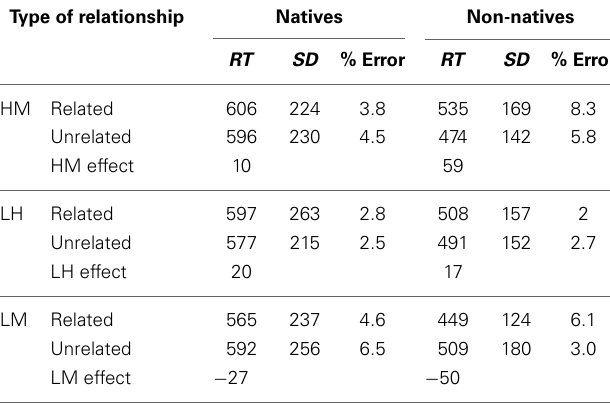
Table 1 | Median reaction times (RT) and percentage of errors (%error) in each phonological condition for the native and non-native group of